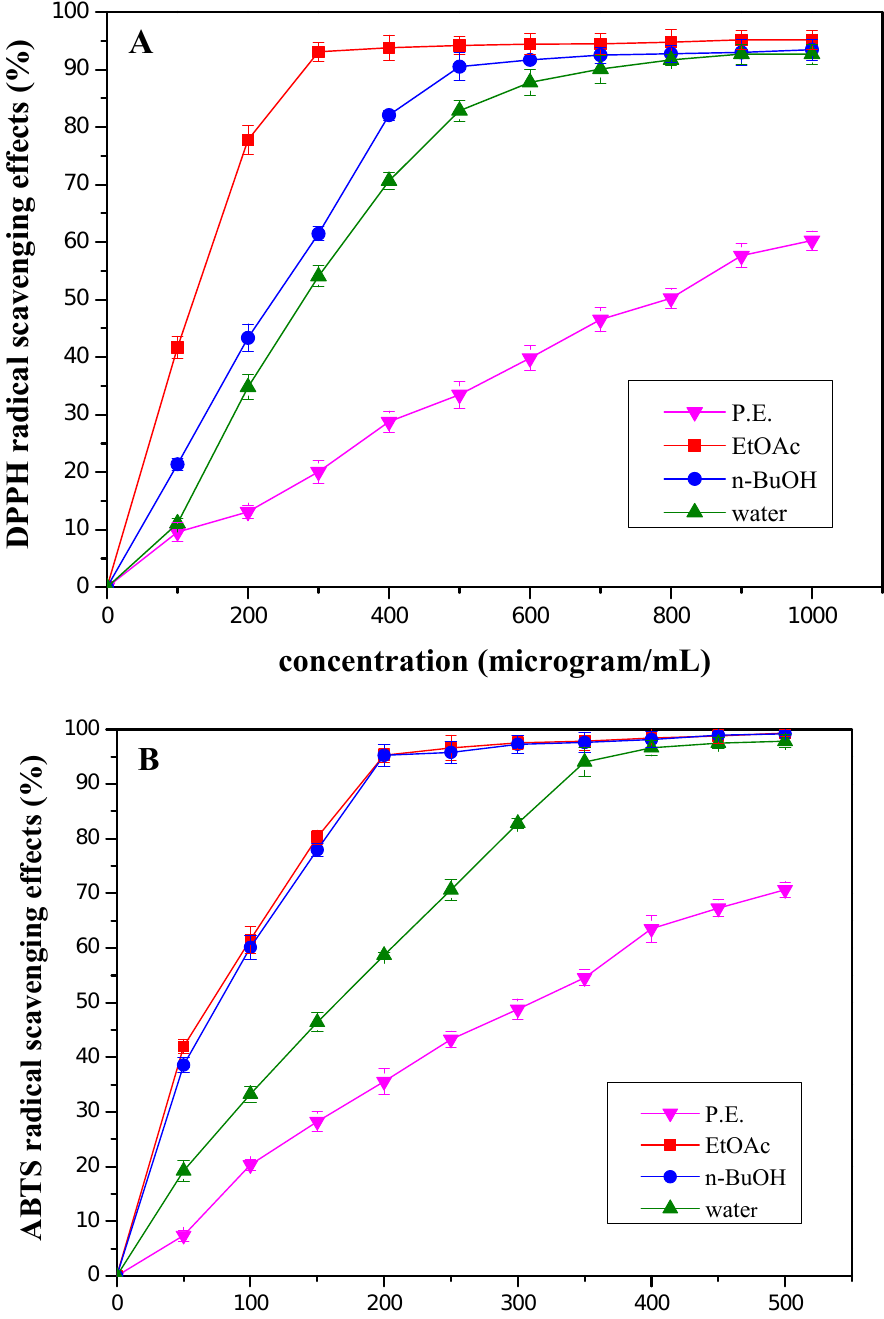
Figure 1. Scavenging activities of different concentrations of the extracts from Microcos paniculata towards (A) DPPH, (B) ABTS and (C) hydroxyl free radicals. Free-radical- scavenging activities were indicated as % inhibition. Each point was performed as mean ± standard deviation (SD) of three